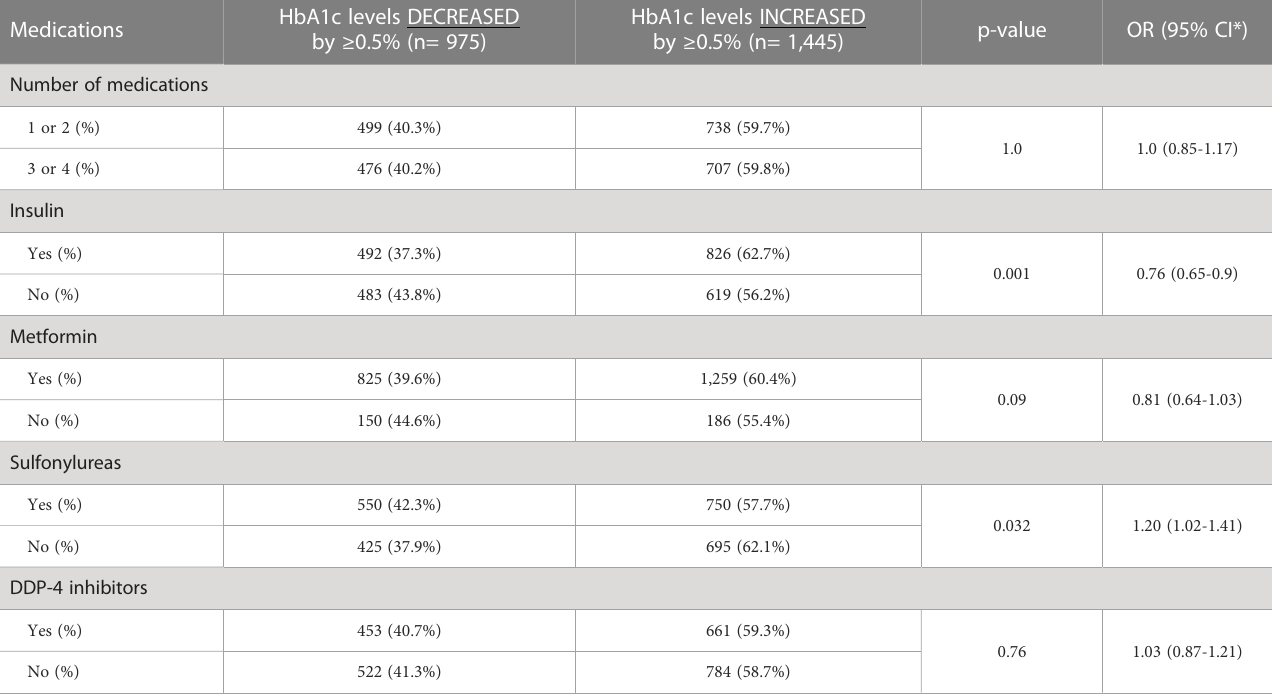
TABLE 4 Impact of number of medications and their categories on directions of changes in HbA1c.